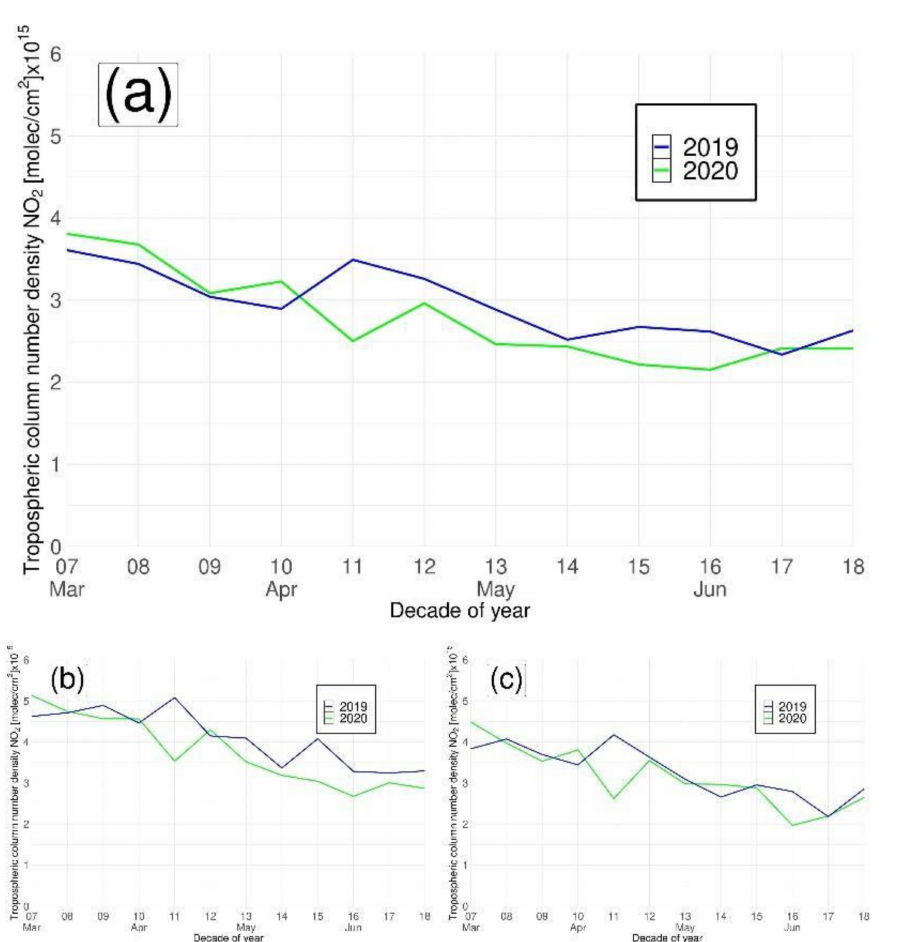
Figure 12. Decade variability of median tropospheric NO 2 column number density (molec/cm 2 · 10 15 ) over Poland ( a ); urban areas in Poland ( b ); and non-built-up areas in Poland ( c ); in 2020 (green line) and 2019 (blue line). The X axis corresponds to a decade of the